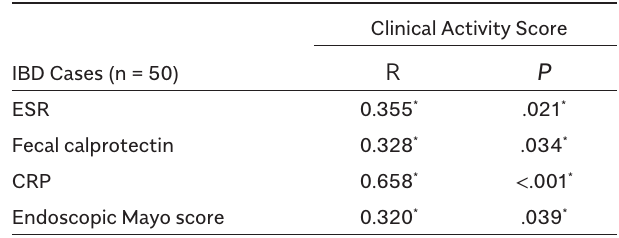
Table 2. Correlation Between Neutrophils/Lymphocytes Ratio with Different Studied Parameters in IBD Cases (n = 50). IBD Cases (n = 50)